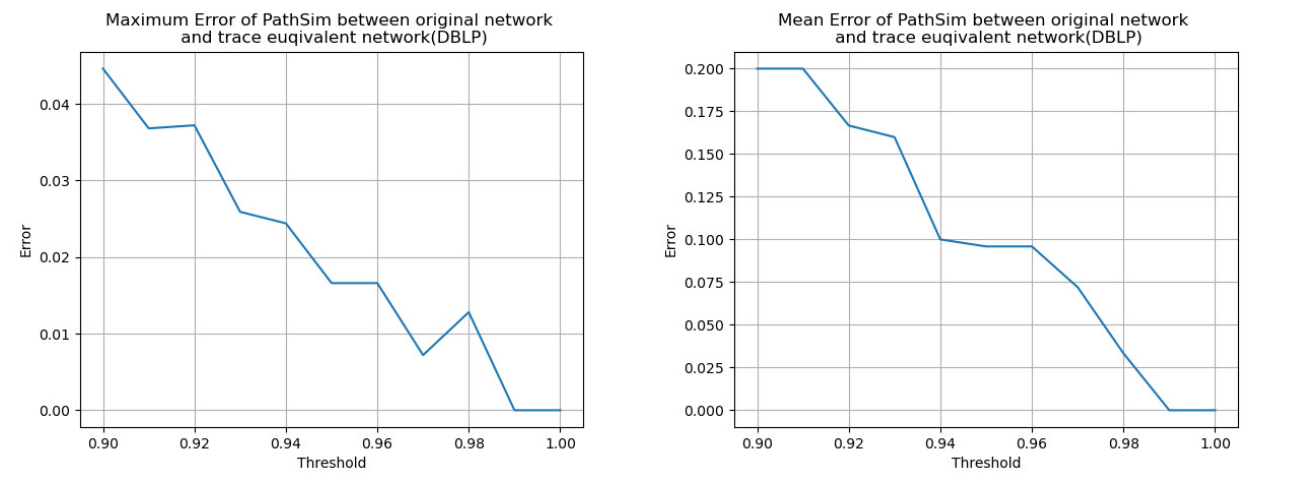
Figure 6. Trend of maximum error ( Left ) and mean error ( Right ) of PathSim on ACM between original network and trace-equivalent network.